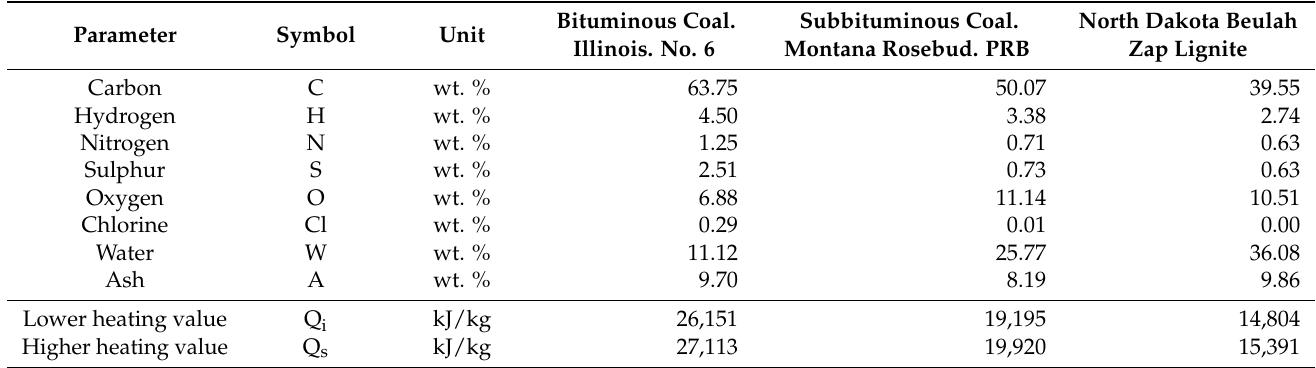
Table 1. Coal properties, as received [30,31].